Question: What style of plot is this figure drawn as?
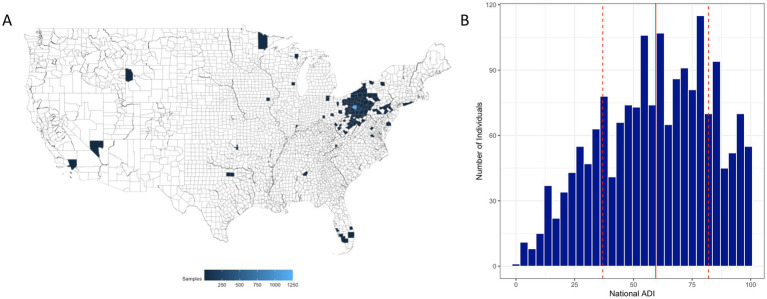
Answer: histogram